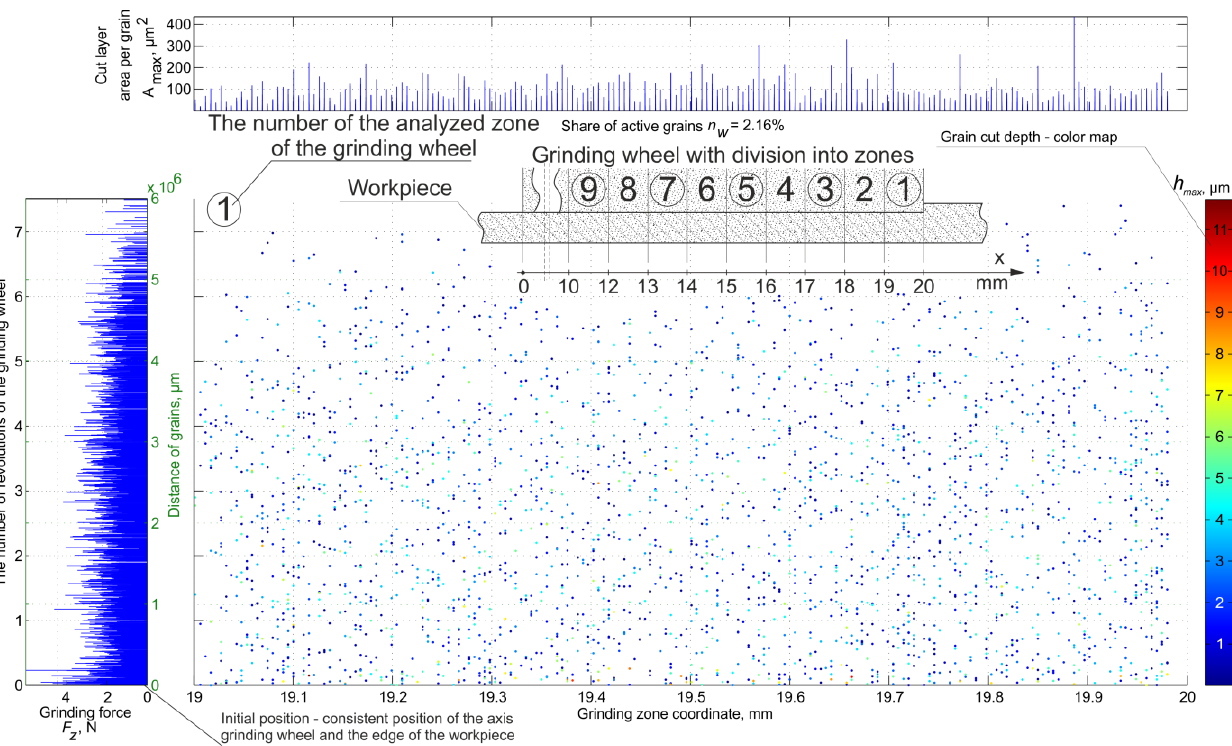
Figure 4. Map of grain activity in the first zone during plane grinding with traverse feed.